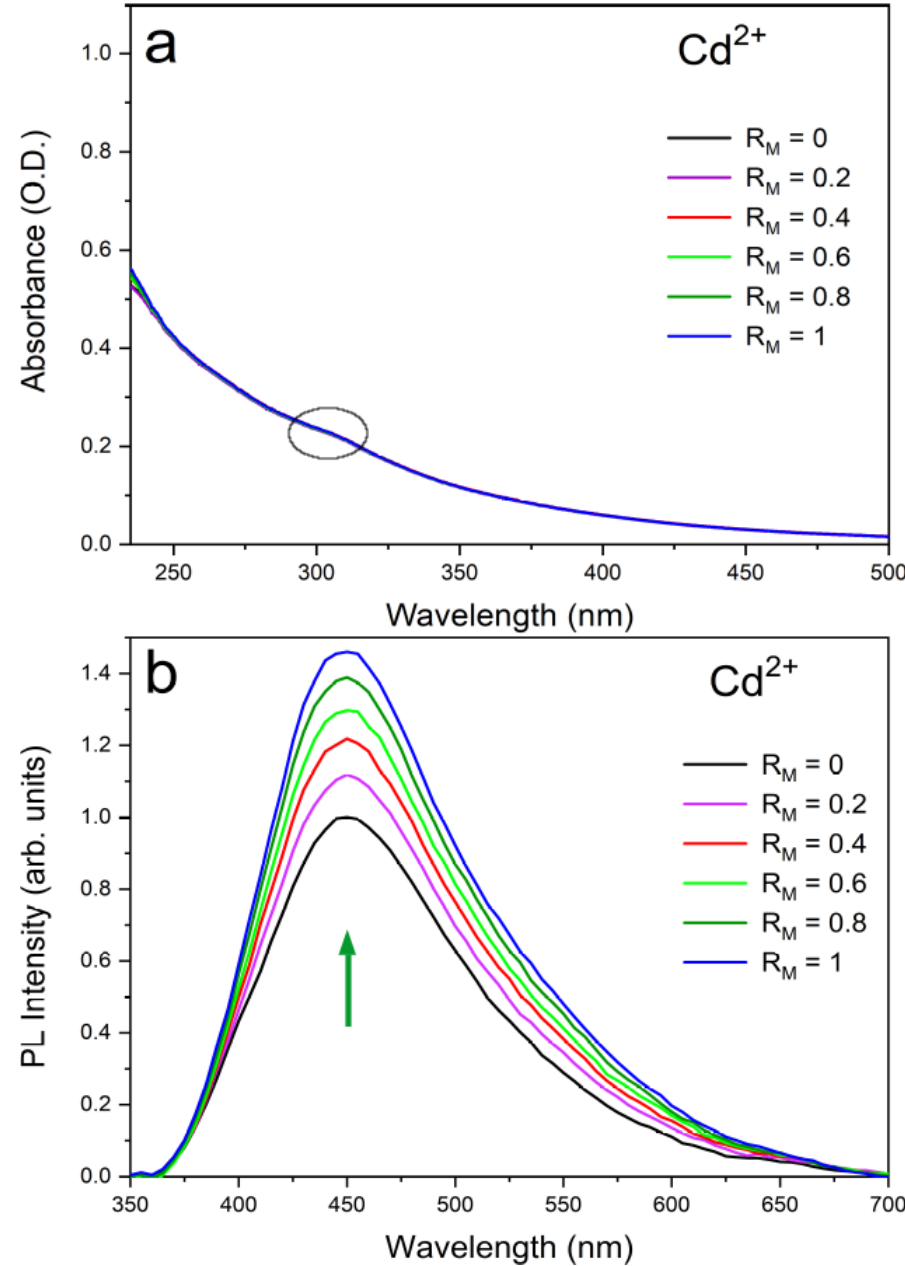
Figure 3. Experimental optical absorption ( a ) and emission ( b ) spectra of the aqueous suspension of UFQDs in the presence of Cd 2 + at different values of the ratio of the respective molar concentrations RM = [Cd 2 + ]/[UFQD]. A maximum increase of 47% in the quantum yield was observed at RM =